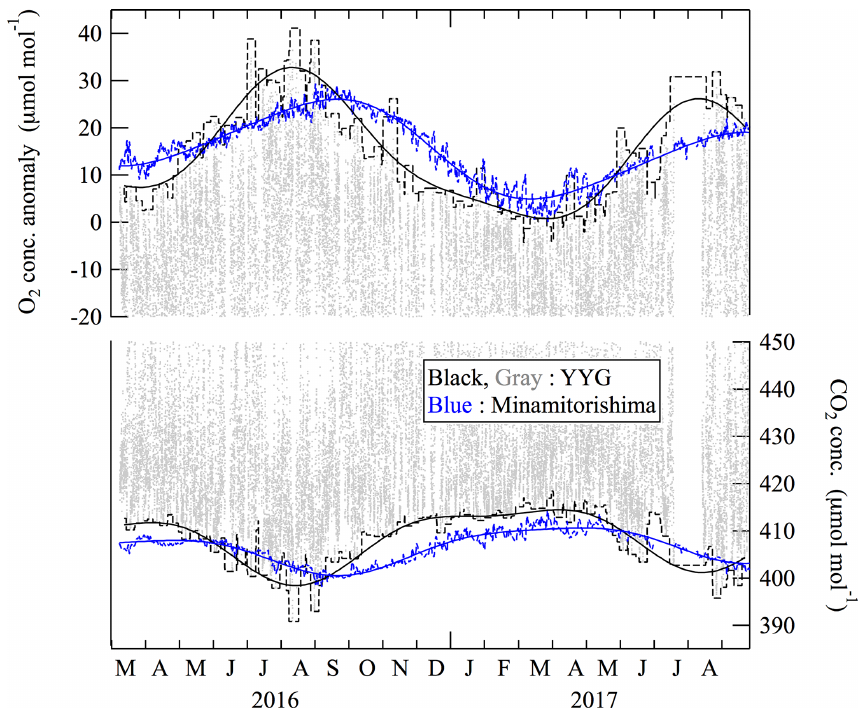
Figure 4. Baseline variations of O 2 and CO 2 concentrations at the tower height of 52m at Yoyogi, Tokyo, Japan, represented by their best- fit curves (black solid lines) to the respective maximum and minimum values during the successive 1-week periods (black dashed lines). Variations of 24h averaged O 2 and CO 2 concentrations at Minamitorishima, Japan (blue dashed line), and their best-fit curves (blue solid lines), are also shown (updated from Ishidoya et al.,